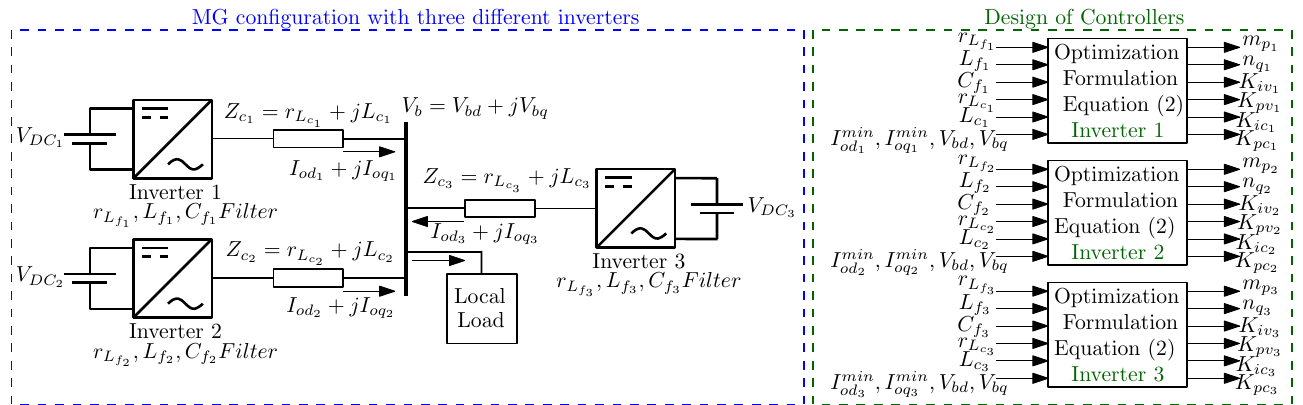
Figure 11. The design of MG controllers for three different inverters with different output impedances.